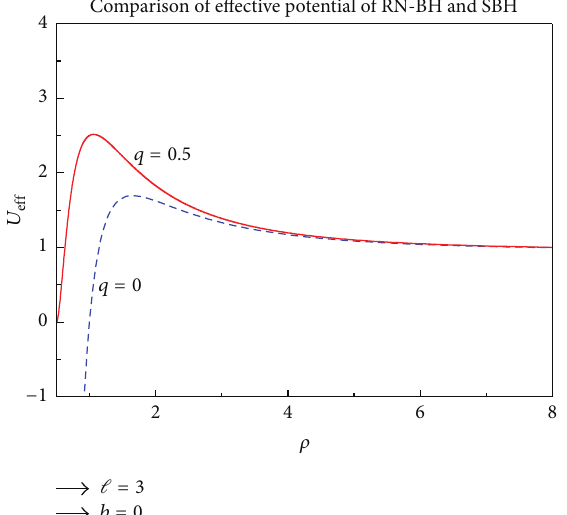
Figure 4: Effective potentials (34) as a function of 𝜌 .